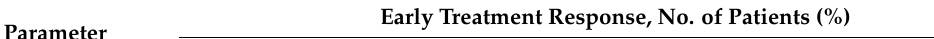
Table 5. Early treatment response and early occurrence of nephrotoxicity according to each cutoff AUC on day 2 in patients with high/moderate-risk and low-risk MRSA